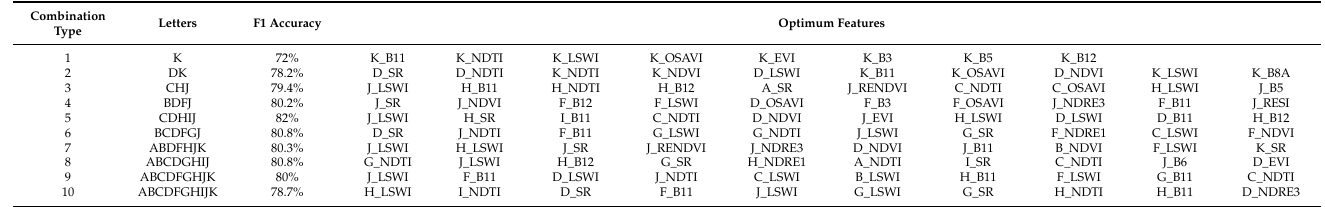
Table A6. Top-10 optimal corn feature sets for different combination types on 12 June 2020.